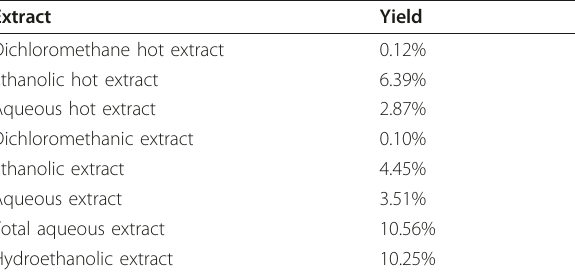
Table 2 DPPH radical scavenging of A. lappa